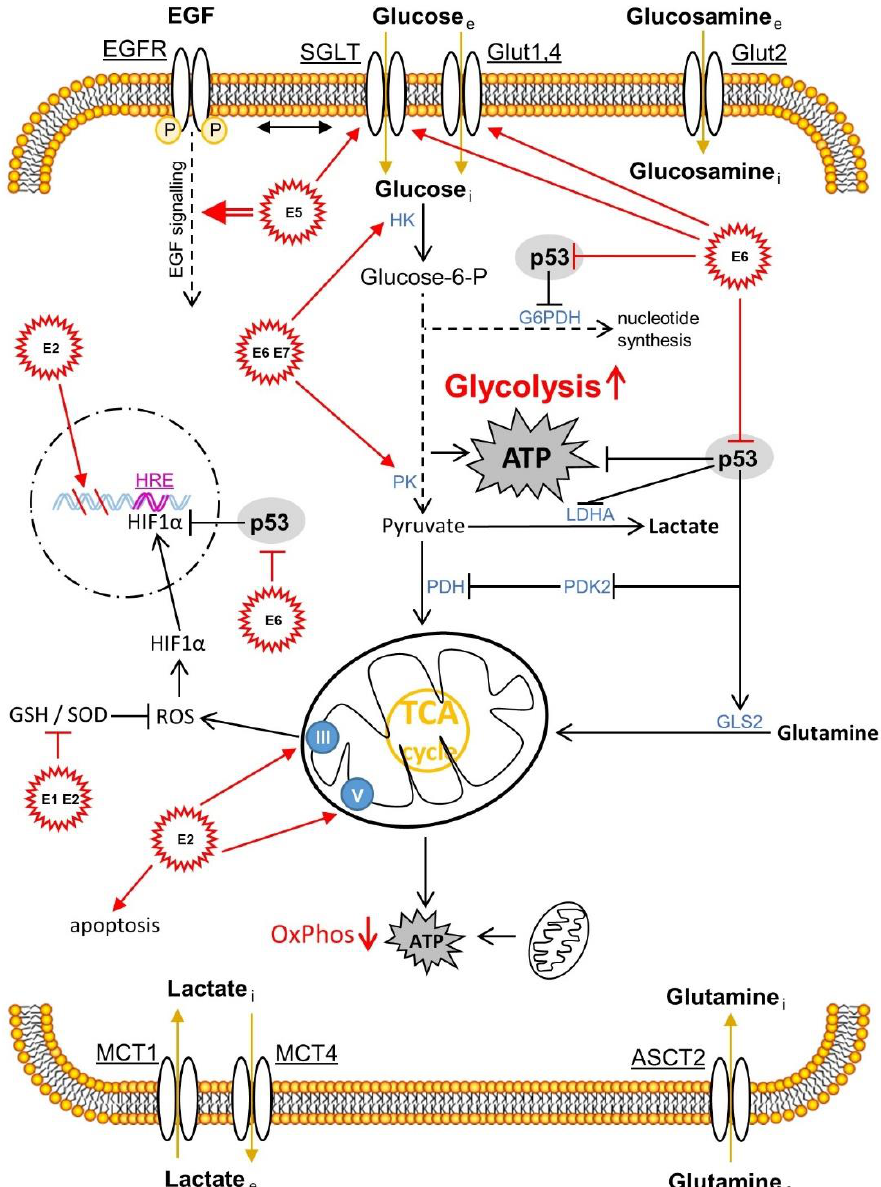
Figure 2. The HPV proteins E1, E2, E5, E6 and E7 and their effects on the metabolism of the transformed cervical tissue. The correlations shown are mainly presented in Section 3.1. ASCT2, amino acid transporter 2; EGF, epidermal growth factor; EGFR, epidermal growth factor receptor; G6PDH, glucose-6-phosphat-dehydrogenase; GLS2, glutaminase 2; Glut, glucose transporter; GSH, glutathione; HRE, hypoxia response element; HIF1 α , hypoxia-inducible factor 1 α ; HK, hexokinase; LDHA, lactate dehydrogenase A; MCT, monocarboxylate transporter; OxPhos, oxidative phosphorylation; PDH, pyruvate dehydrogenase; PK, pyruvate kinase; PDK2, pyruvate dehydrogenase kinase isoform 2; ROS, reactive oxygen species; SGLT, sodium glucose transporter; SOD, superoxide dismutase. Reproduced from